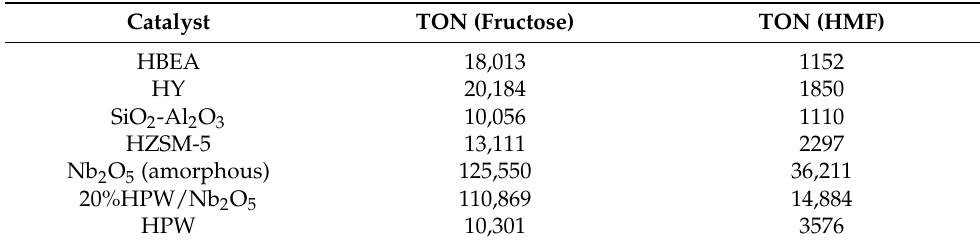
Table 4. Turnover number a for fructose reaction and HMF formation for the different catalysts